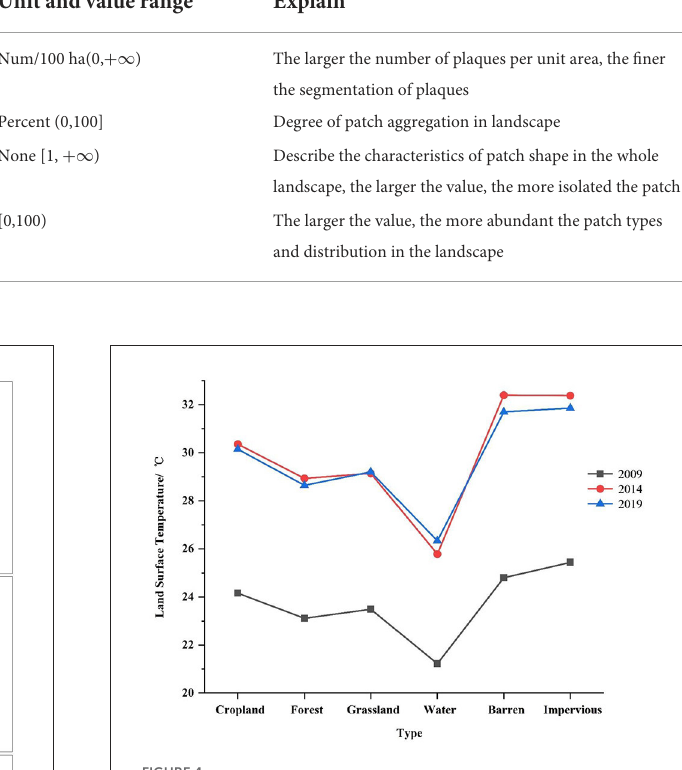
FIGURE4 Land mean surface temperature changes in 2009, 2014, and 2019 by local table